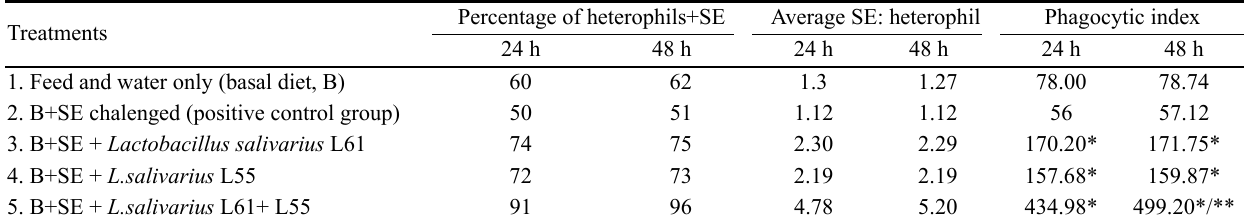
Table 3. Effects of Lactobacillus treatment on chicks’ heterophil phagocytosis at 24 h and 48 h after Salmonella Enteritidis (SE) infection